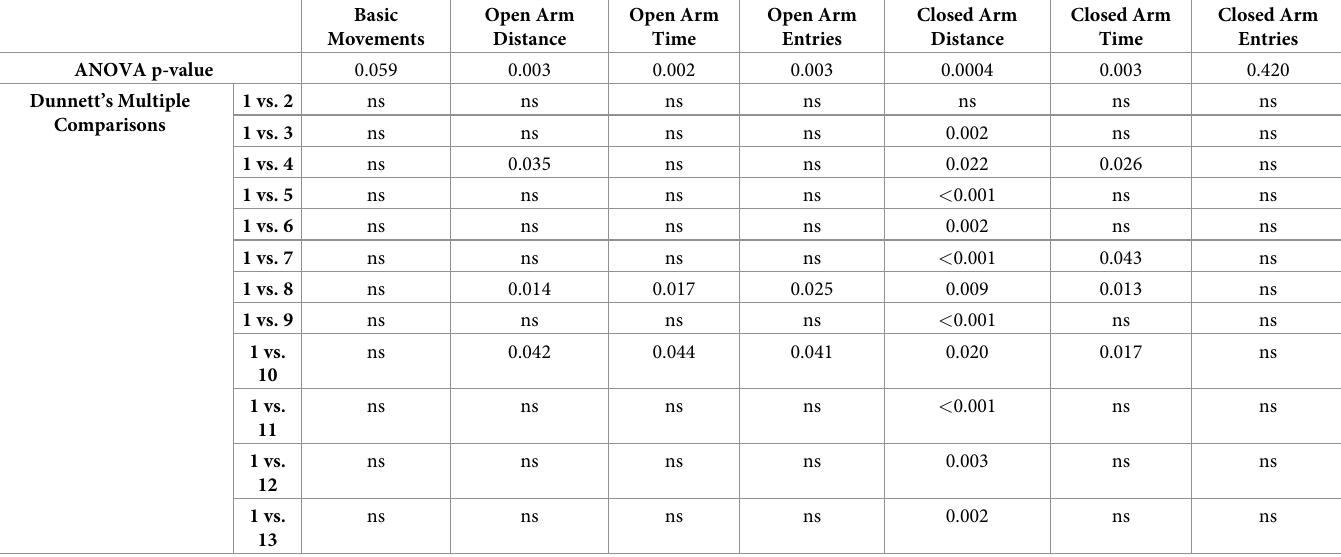
Table 1. Statistical results of raw data from Experiment 1. Repeated-measures one-way ANOVA and Dunnett’s post-hoc test results showing main effects of time across repeated trials for basic movements, open/closed arm distance, open/closed arm time, and open/closed arm entries. Trials not significantly different from the first trial are reported as “ns”; trials that differ significantly from the first trial are reported with an associated p-value.